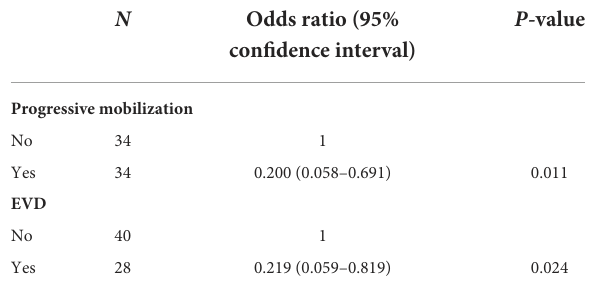
TABLE 3 Multivariate logistic regression analysis of cerebral vasospasm.